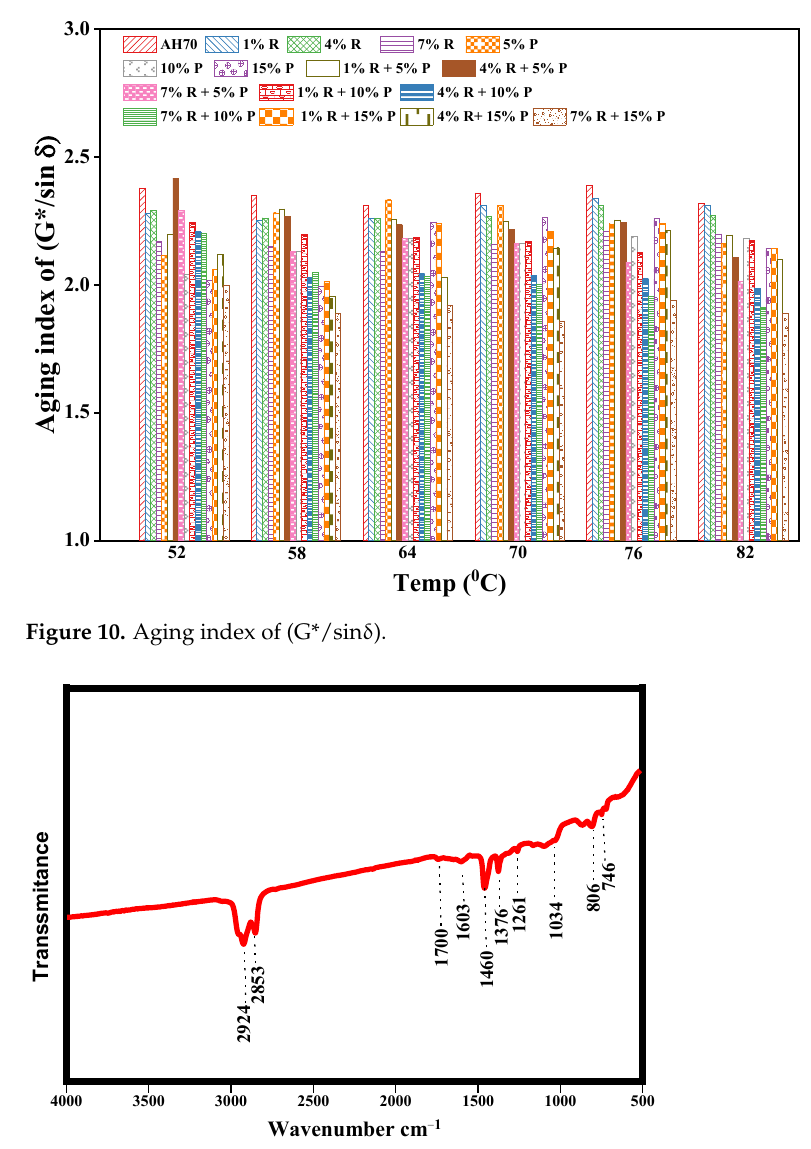
Figure 11. FTIR spectra of neat asphalt binder.